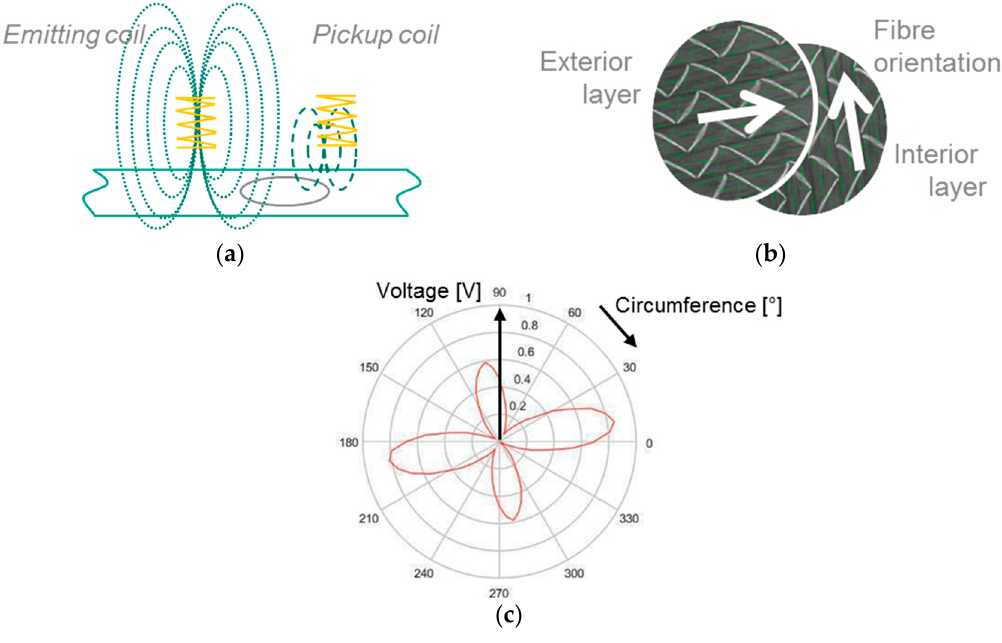
Figure 1. ( a ) Hal-transmission probe arrangement [9]; ( b ) two-layer material specimen; and ( c ) anisotropically induced voltage measured in pickup coil.